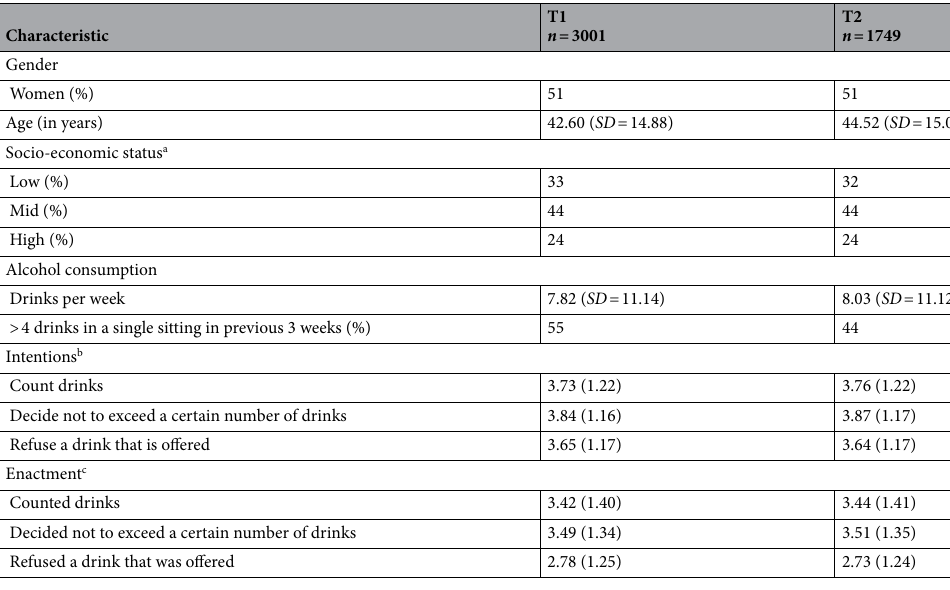
Table 2. Sample profile and descriptive statistics for intentions and enactment (T1 and T2). Enactment intentions were measured on a scale of 1 ( Very unlikely ) to 5 ( Very likely ). A Do not intend to drink alcohol option was also provided (treated listwise). Enactment was measured on a scale of 1 ( Never ) to 5 ( Always ). A Not applicable option was also provided (treated listwise). T1 = Time 1. T2 = Time 2. a As per Australian Bureau of Statistics’ Index of Relative Disadvantage 26 . b Do not intend to drink alcohol responses—T1: n = 145, T2: n = 122. c Not applicable responses—T1: n = 461, T2: n =